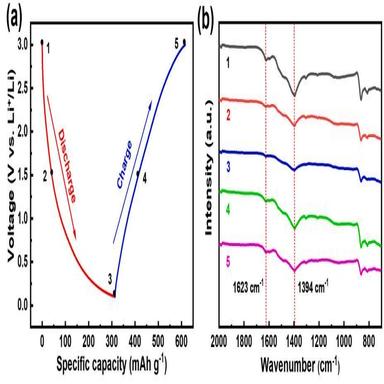
(a) Charge-discharge curves of PDHTA, and (b) in-situ FT-IR of different voltages corresponding to PDHTA electrodes.